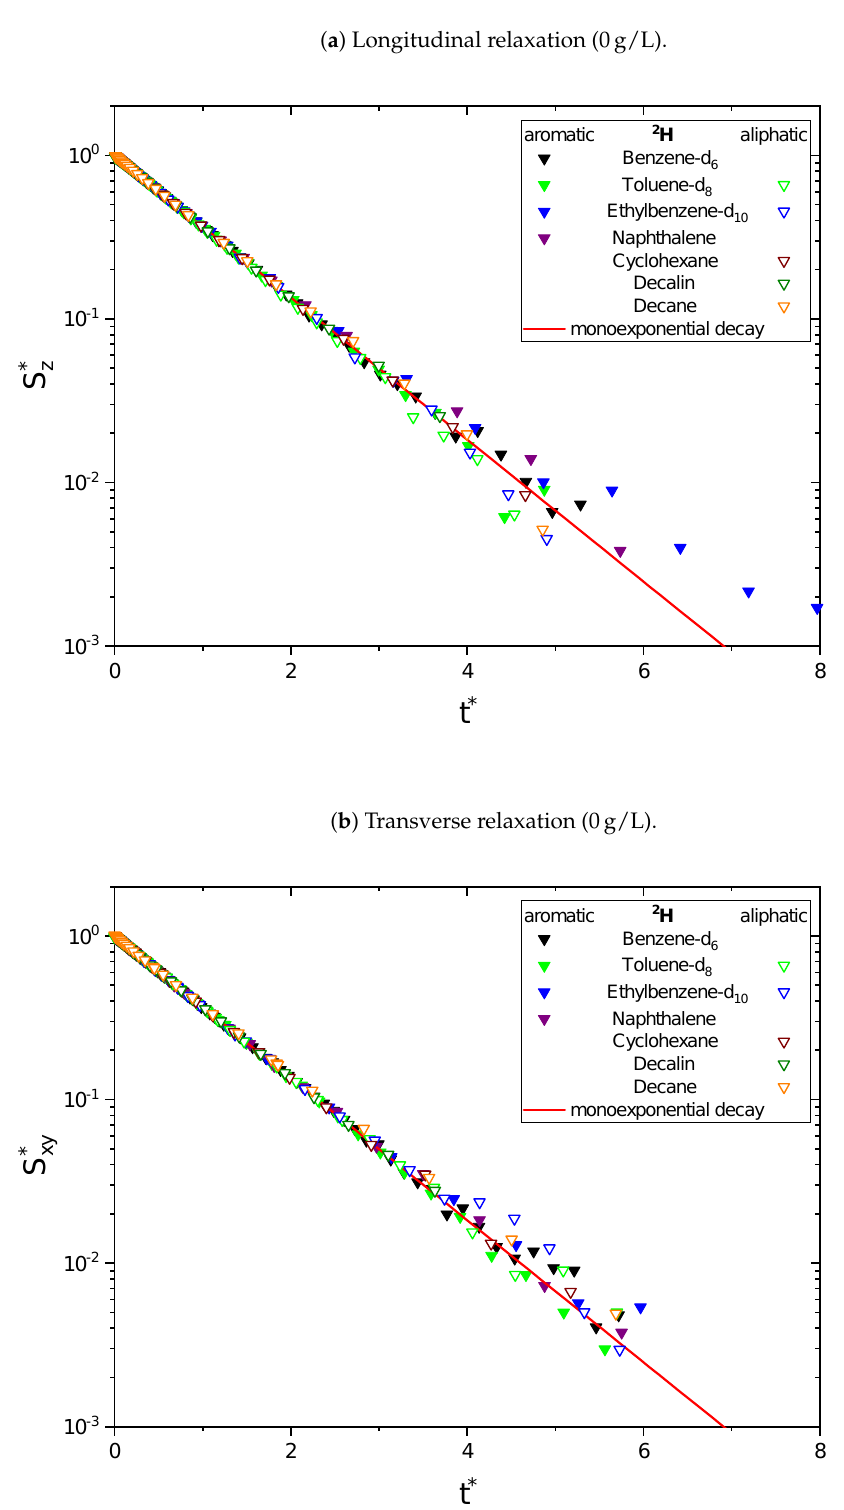
Figure 3. Longitudinal ( a ) and transverse ( b ) relaxation decays of the maltene deuterons in the asphaltene-free solution, consisting of 95vol% benzene and 5vol% of the investigated deuterated maltene. For a qualitative comparison, the time axis is rescaled (see Equation (12)) to reflect multiples − 1 ∗ = 0 (see Equations (13) and (14)). The needed of R 1,2 , and the signal is normalized to unity at t parameters were obtained from a monoexponential ( (cid:79) )